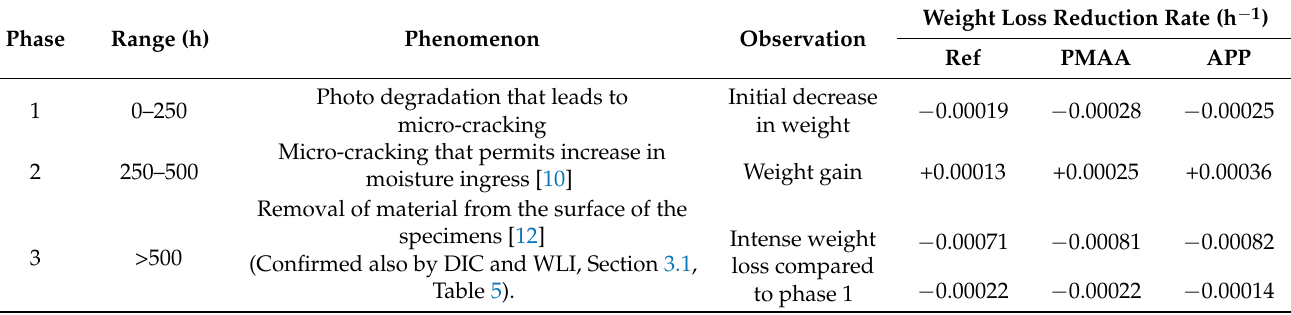
Table 4. Degradation phases and weight loss reduction rate.